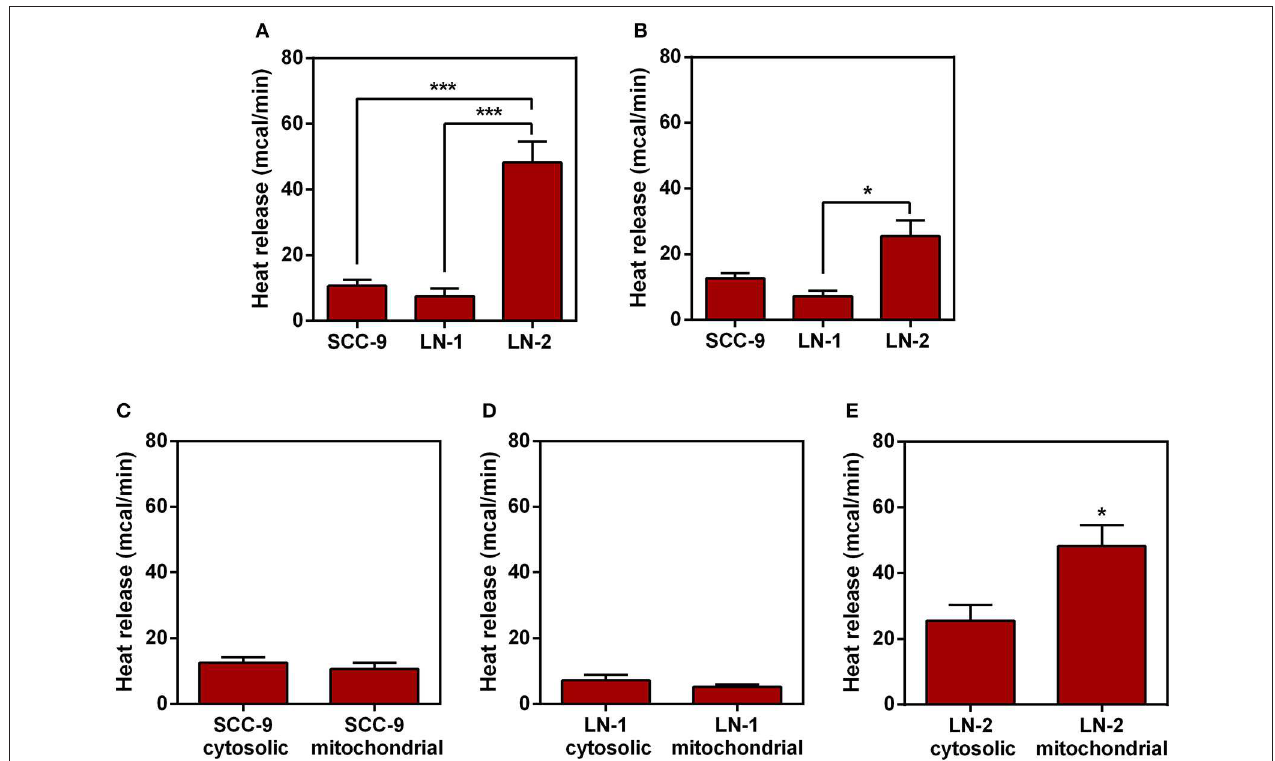
FIGURE 7 | Comparison of heat release by protein extracts enriched with mitochondrial or cytoplasmic fractions.The protein extracts were obtained from human oral squamous carcinoma cells SCC-9, LN-1 and LN-2. The bars represent the release of total heat of protein extracts in 35min of experiment. (A) Protein extracts enriched with mitochondrial fraction of SCC-9, LN-1 and LN-2; (B) protein extracts enriched with cytoplasmic fraction of SCC-9, LN-1 and LN-2; (C) protein extracts enriched with mitochondrial and cytoplasmic fractions of SCC-9 cells; (D) protein extracts enriched with mitochondrial and cytoplasmic fractions of LN-1 cells; (E) protein extracts enriched with mitochondrial and cytoplasmic fractions of LN-2 cells. Values were expressed as mean ± SEM. * p < 0.05; *** p < 0.001.